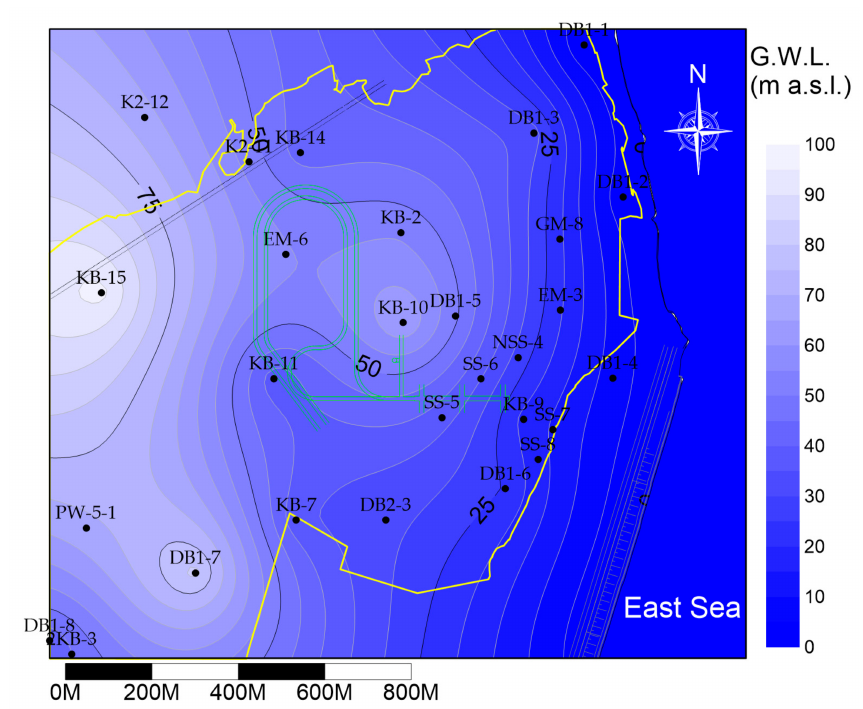
Figure 3. Groundwater head contours (a.m.s.l., m) in the study